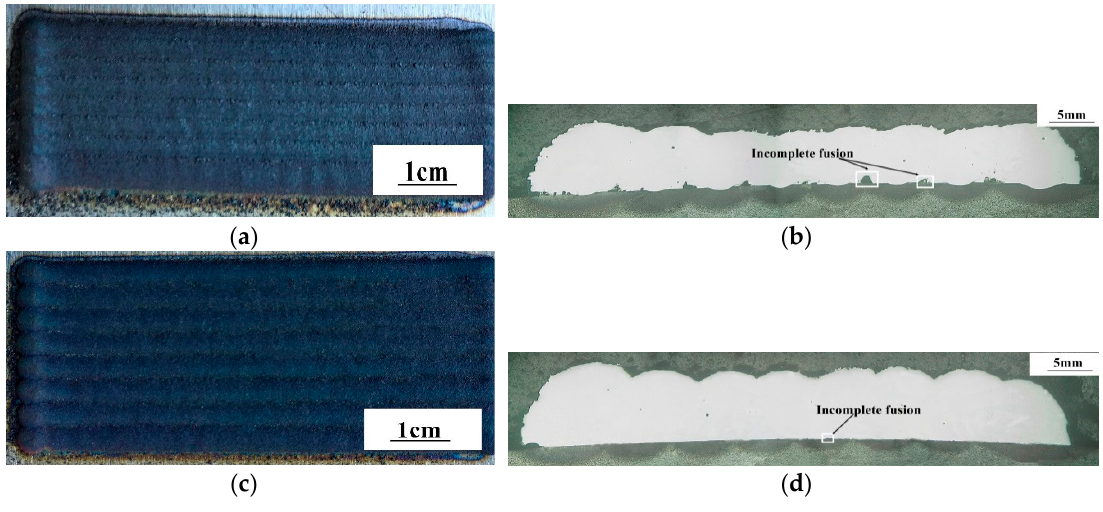
Figure 5. Multi-track laser clad morphology and cross-section comparison between the best parameter set from the orthogonal design ( a , b ) and the optimal GRA parameter set ( c , d ).